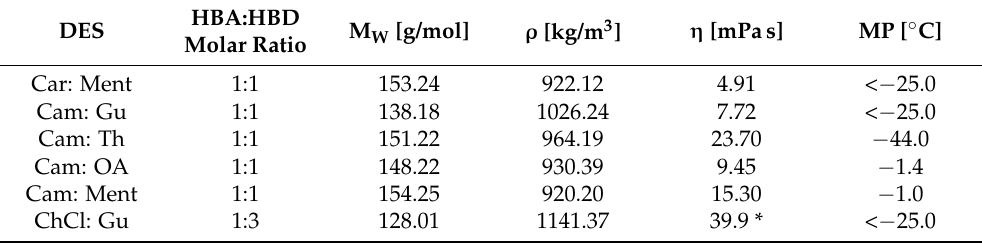
Table 1. Basic physical properties of DESs crucial for the efficient extraction.